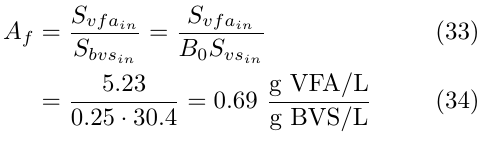
Table 4: Data used to calculate parameter A f Time S vs